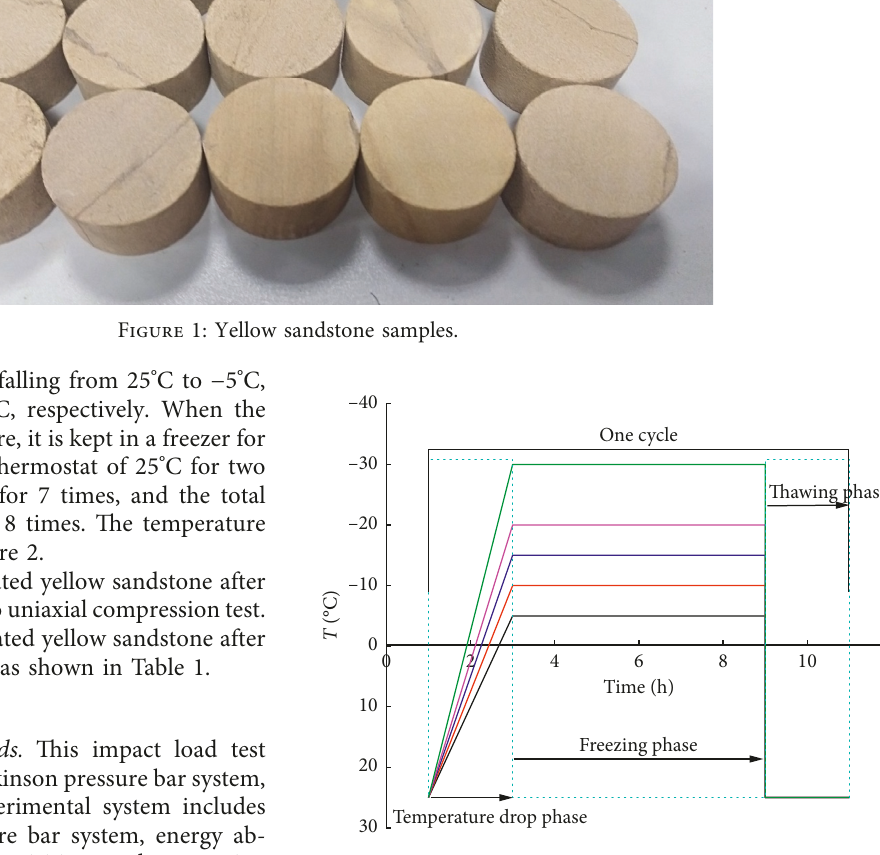
Figure 2: Temperature-time curve of freeze-thaw